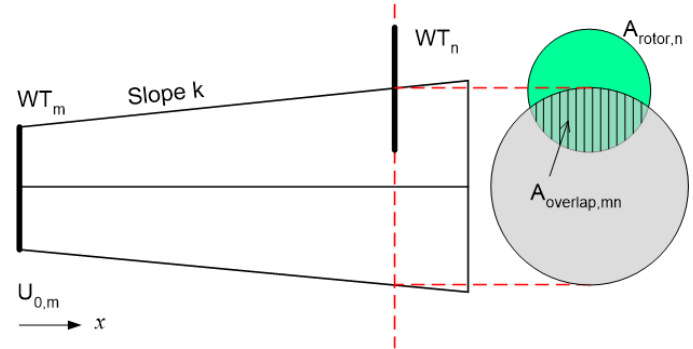
Figure 1. Illustration of the overlapping area used in the Park2 model.